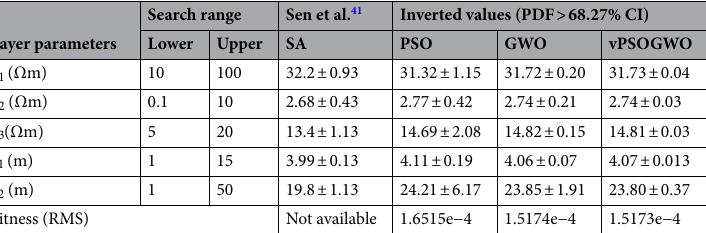
Table 6. Mean model with the level of uncertainty in the posterior utilizing individual inversion of DC data from PSO, GWO, vPSOGWO, compared with results inverted by Sen et al. 41 over Digha, Medinipur (WB),